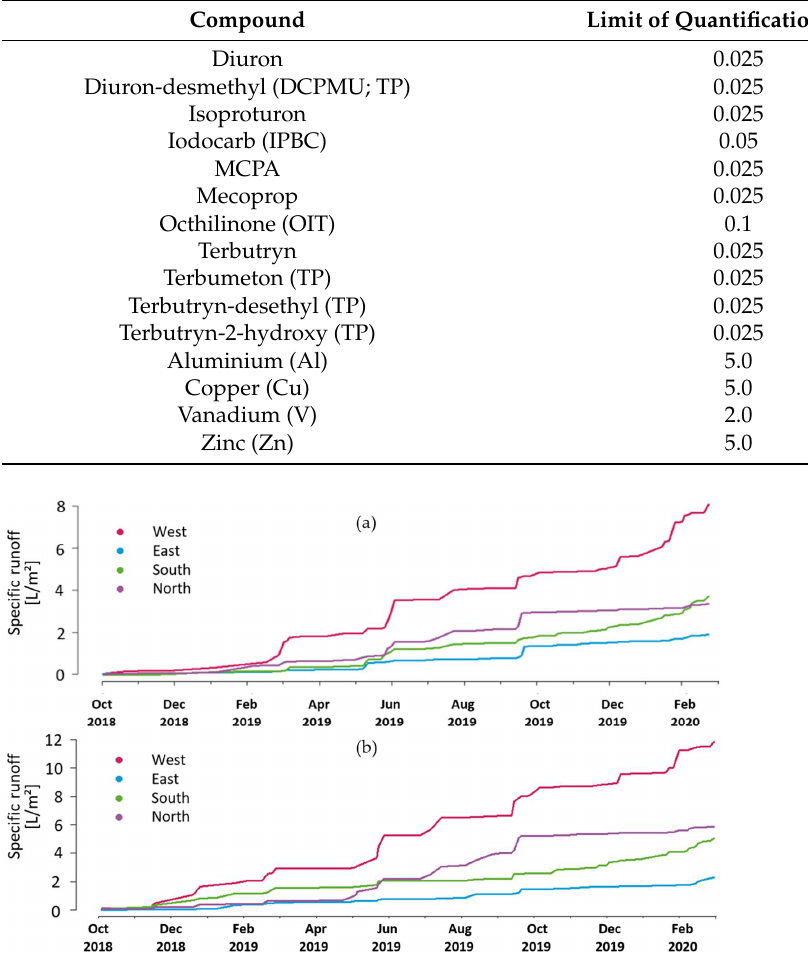
Figure A5. Cumulated specific façade runoff for site A ( a ) and site B ( b ).